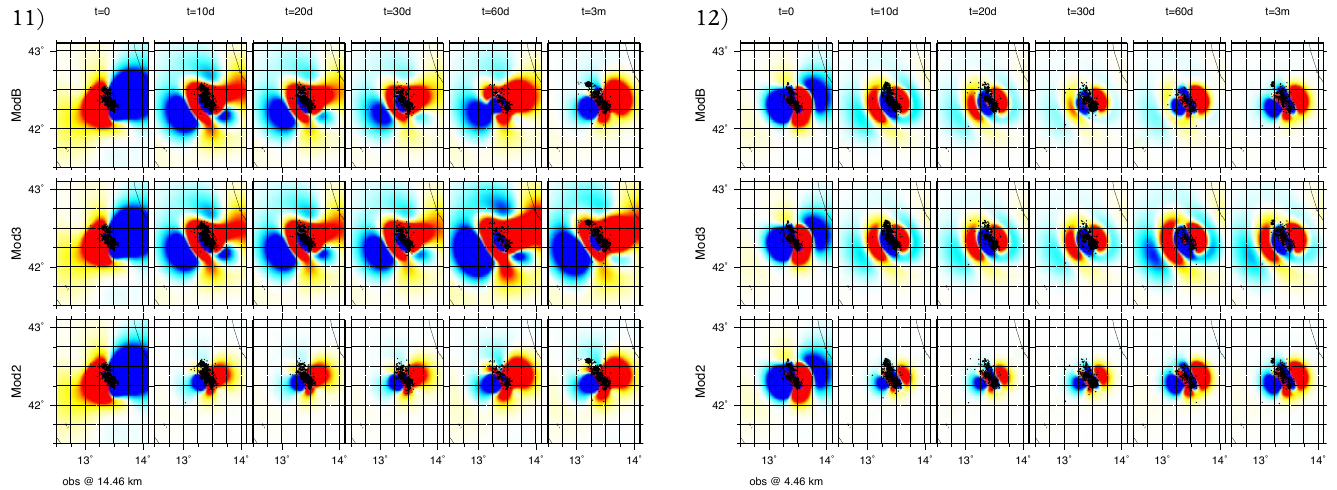
Figure 11. Temporal evolution of the post-seismic CFF associated with the 2009 L'Aquila earthquake, for the different rhelogical models (as indicated; see Table 2) at the temporal steps of t = 0, 10, 20, 30, 60 days, and 3, 4 and 6 months (as indicated), each with respect to the previous time step, except for t = 0, which represents the reference co-seismic CFF. The observer is located at 14.46 km in depth. The CFF is expressed in Pascal (Pa). For the first step, the color scale range has to be multiplied by a factor of 10. For each temporal step, the distribution of aftershocks with depth ≥ 9.46 km is also shown (black dots). Figure 12. As for Figure 11, with the observer located at 4.46 km of depth. For the first step, the color scale range has to be multiplied by a factor of 5. For each temporal step, the distribution of aftershocks with depth ≤ 9.46 km is also shown (black